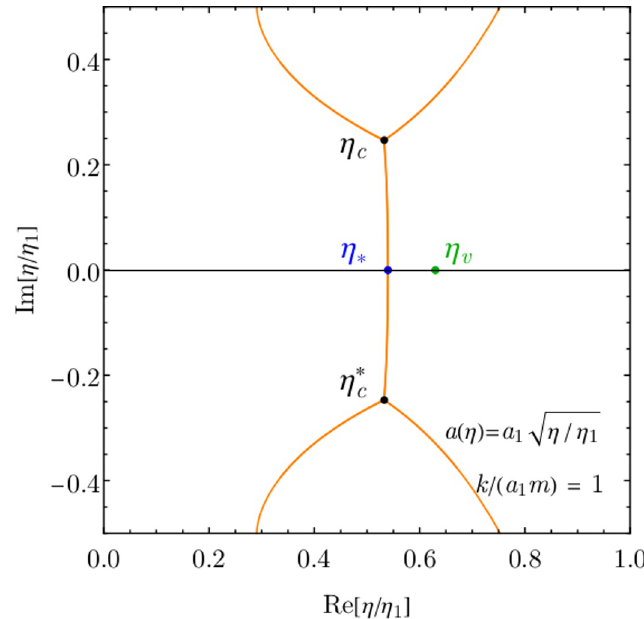
Figure 7 . An illustration of the complex- η plane showing turning points η c and η ∗ and Stokes lines (orange curves) close to the real axis. The early Stokes region containing η → 0 and the late Stokes region containing η → + ∞ share a common border at the central Stokes line shown here. The real axis intersects this Stokes line at the blue dot. The green dot is the point of vanishing sound speed c s . As k → + ∞ , the black and blue dots approach the green